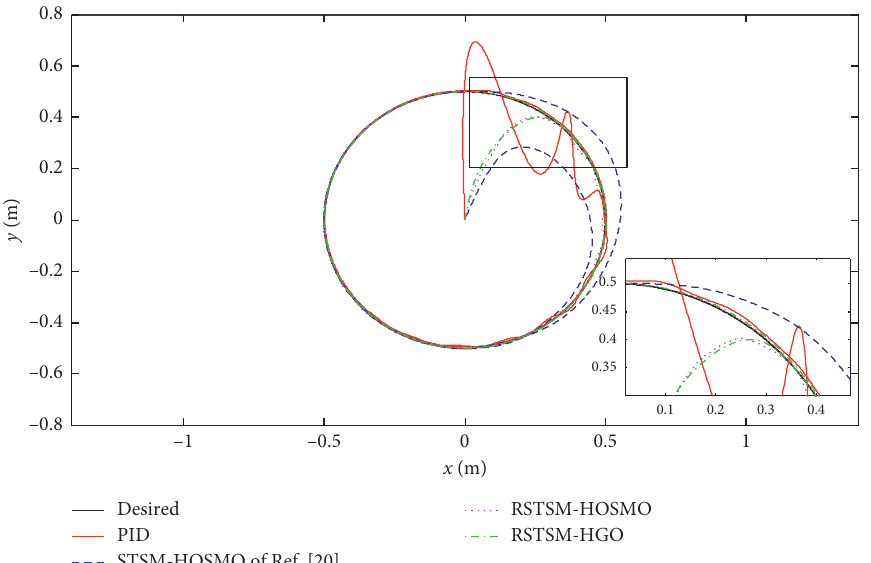
Figure 11: Circular reference trajectory tracking response diagram with disturbance.